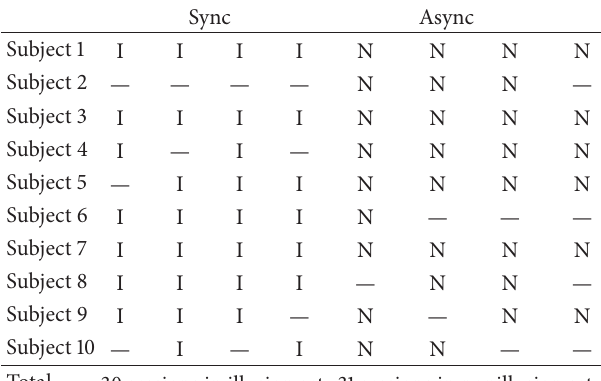
Table 1: The number of sessions in illusion and nonillusion set. “I” means that the participant answered (Q1) + (Q2) ≥ 10 after the session in synchronous condition, and “N” means that the participant answered (Q1) + (Q2) ≤ 6 in asynchronous condition. We got 30 sessions where participants experienced the illusion and 31 sessions where participants did not experience the illusion at all and defined those sessions as illusion set and nonillusion